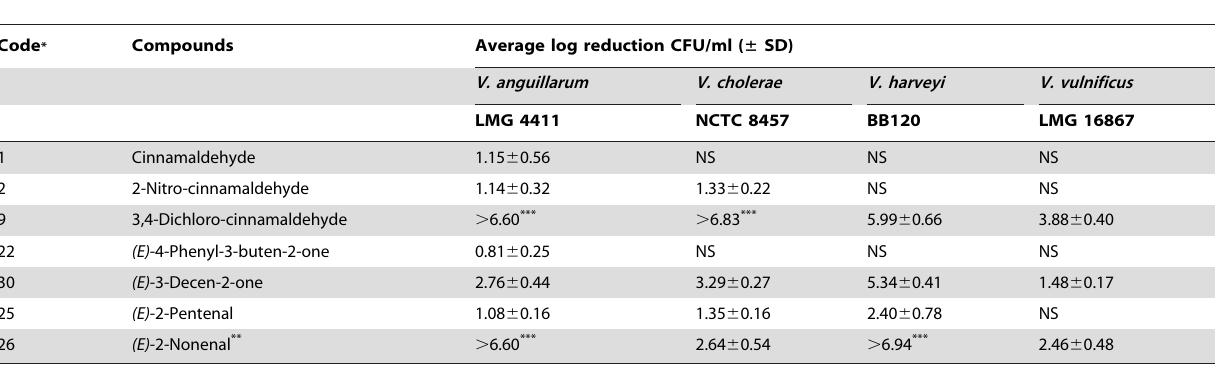
Table 4. Effect of the QS inhibitors on the QS regulated starvation response (data are presented as average log reduction in CFU/ ml after 48 h compared to an untreated control).